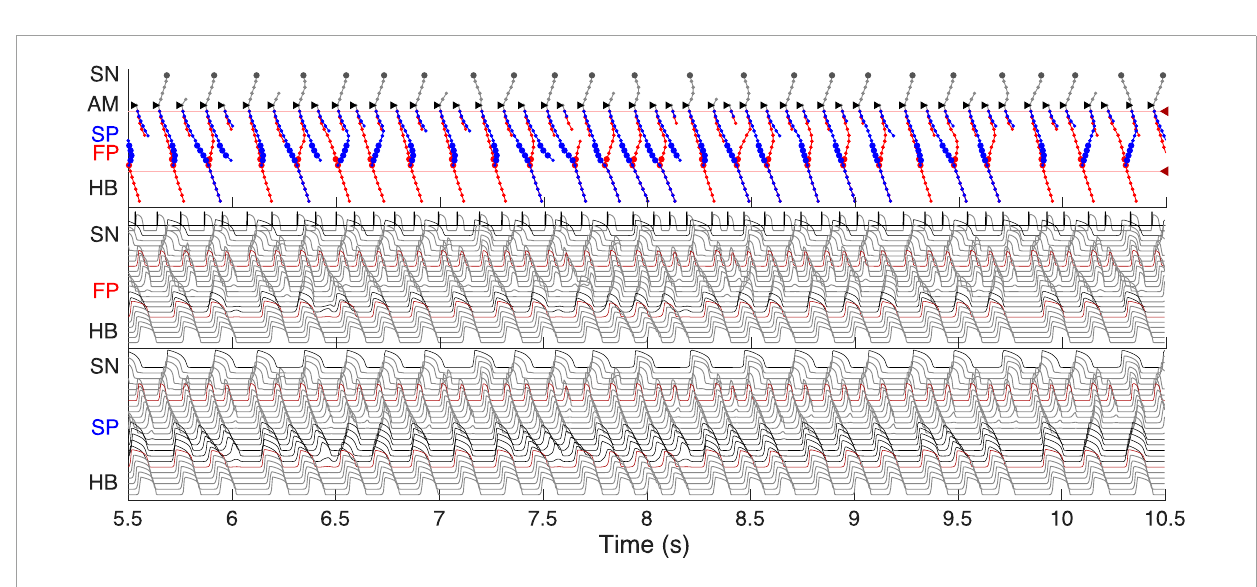
FIGURE 11 Filtering of atrial rhythm during atrial fibrillation stimulated by random impulse sequence in 75–125 ms range applied to AM * model cell. The short stimulation impulses and resulting AM * cell action potentials are shown in the top part of the middle panel.